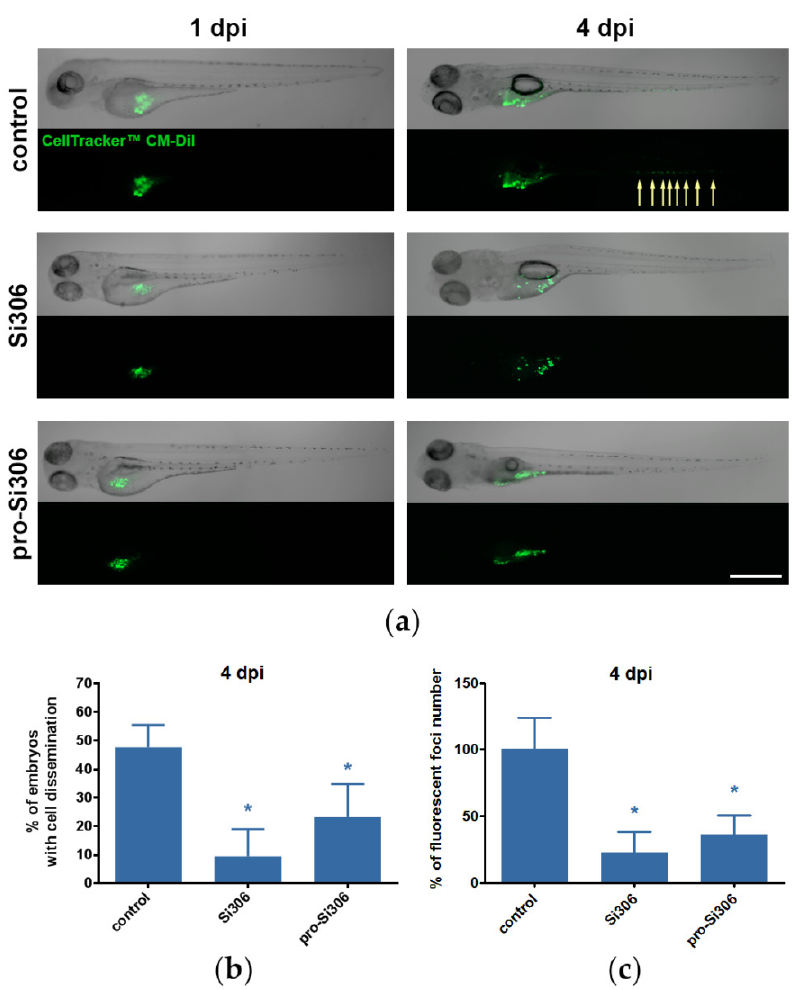
Figure 8. Si306 and pro-Si306 suppress invasion of GBM cells in vivo. ( a ) Representative panorama images of U87 xenografts in zebrafish embryo model at 1 dpi (before treatment) and 4 dpi (after 72 h treatment with 2.5 µ M Si306 and pro-Si306). Arrows indicate dissemination of cells outside of the yolk sac. Scale bar = 500 µ m. ( b ) Percentage of embryos with cell dissemination after 72 h treatment with Si306 and pro-Si306. ( c ) Percentage of fluorescent foci number in embryos displaying invasion after 72 h treatment with Si306 and pro-Si306. All values are expressed as mean ± SEM. Statistical significance between treated and control group is shown as * ( p < 0.05).